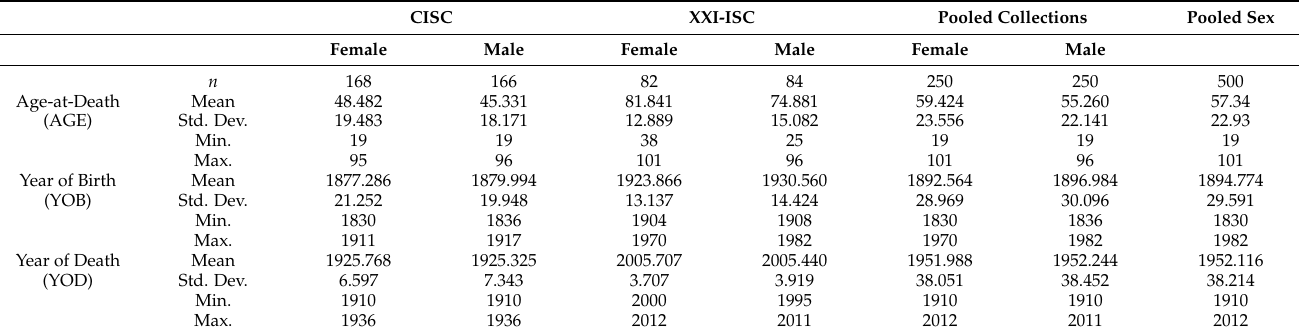
Table 1. Demographic characterization of reference data sampled from the CISC and XXI-ISC